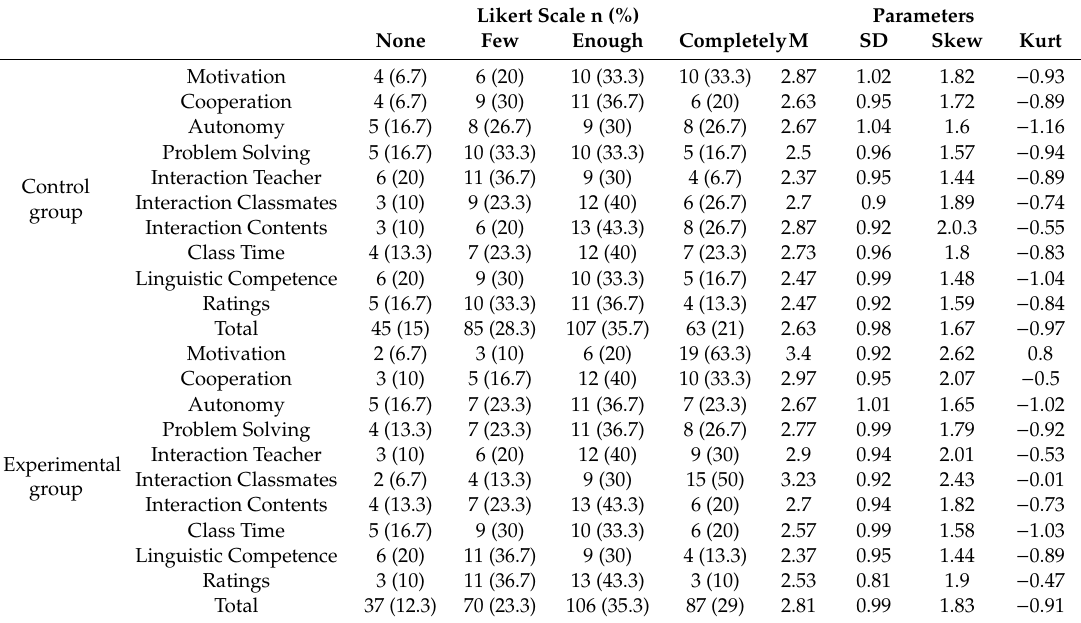
Table 2. Parametric analysis of the results reported in both groups (control and experimental). Likert Scale n